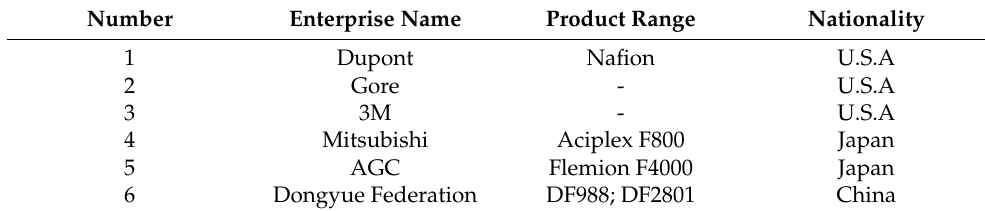
Table 3. PEM manufacturers and their products.